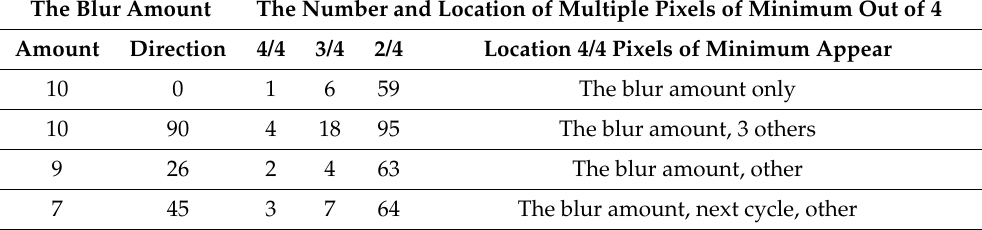
The blur amount, next cycle,